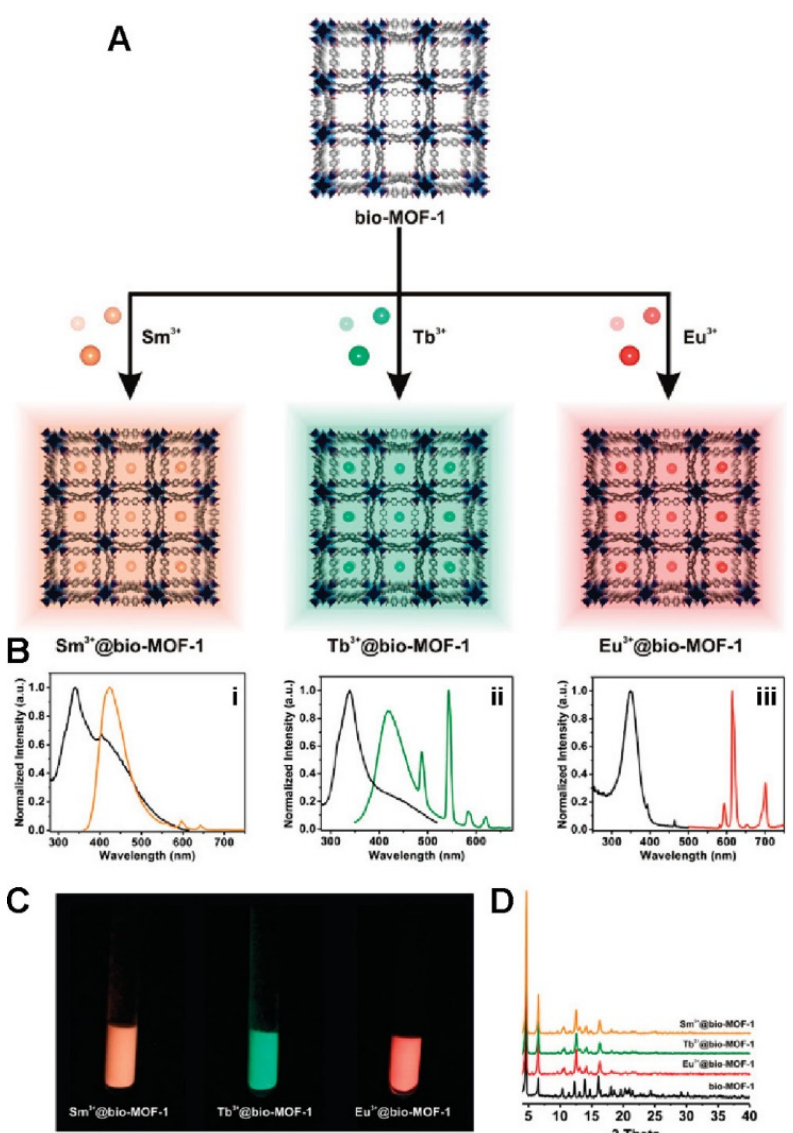
Figure 5. ( A ) Bio-MOF-1 encapsulation and sensing of lanthanide cations and ( B ) Bio-MOF-1 with transition metals cations: absorption and emission spectra. Reprinted with permission from Ref.